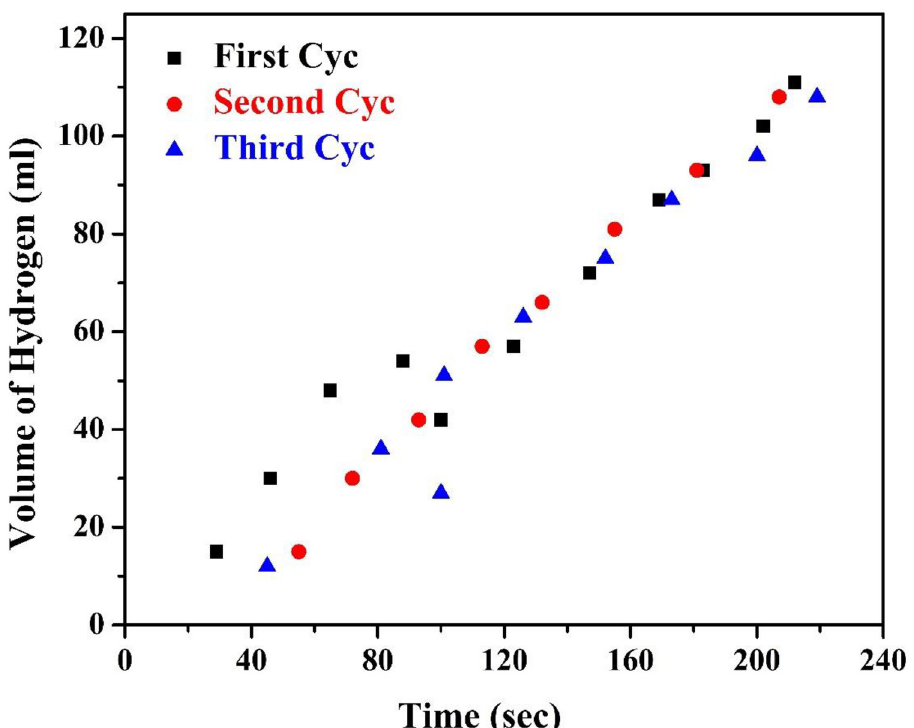
Fig 6. Effect of multiple use of the introduced 0.5% Cd